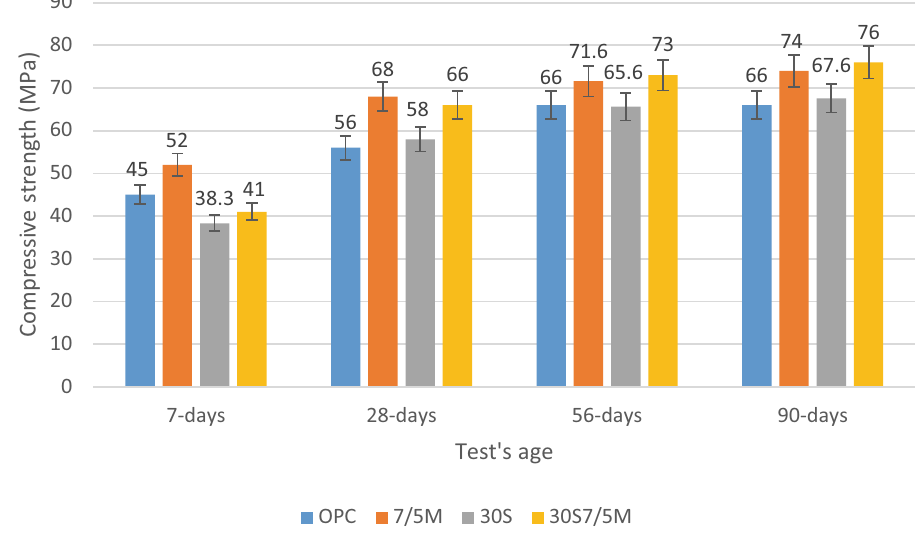
Fig. 7 The compressive strength of cement-based mortars at various